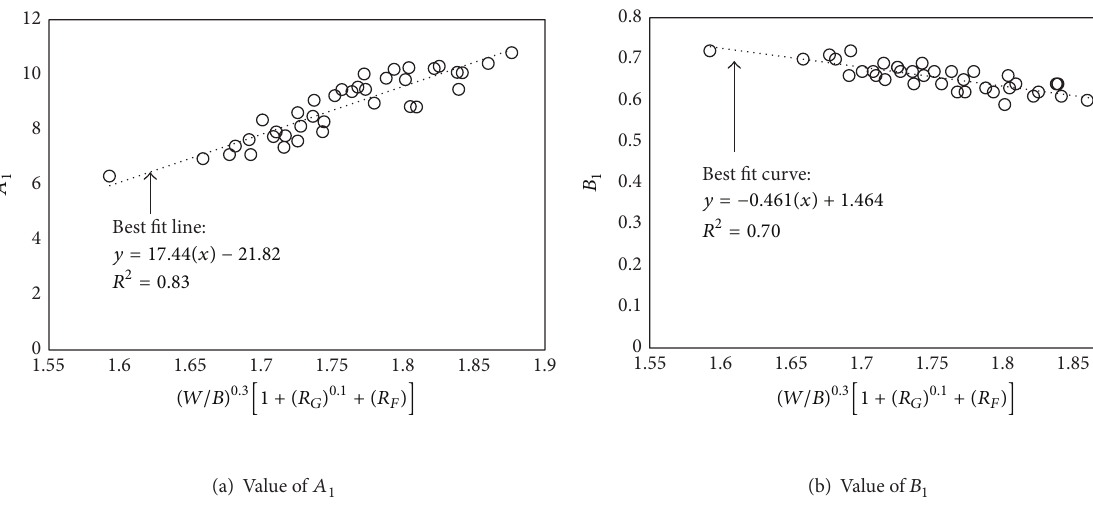
Figure 6: Regression analysis for constants 𝐴 1 and 𝐵 1 in